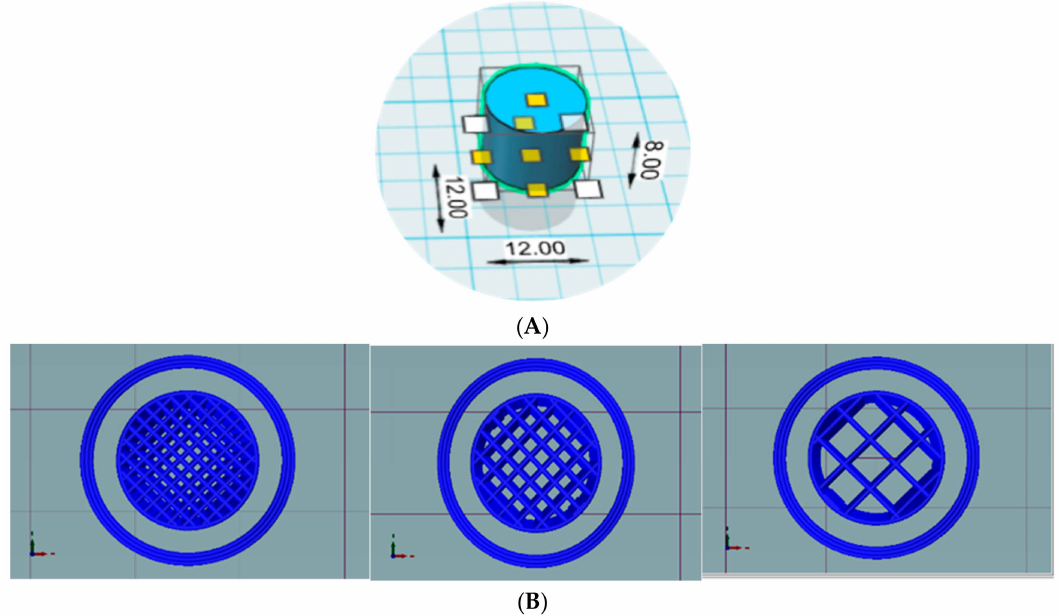
Figure 1. Design and internal structures of tablets. Design of preliminary cylindrical tablets ( A ) and